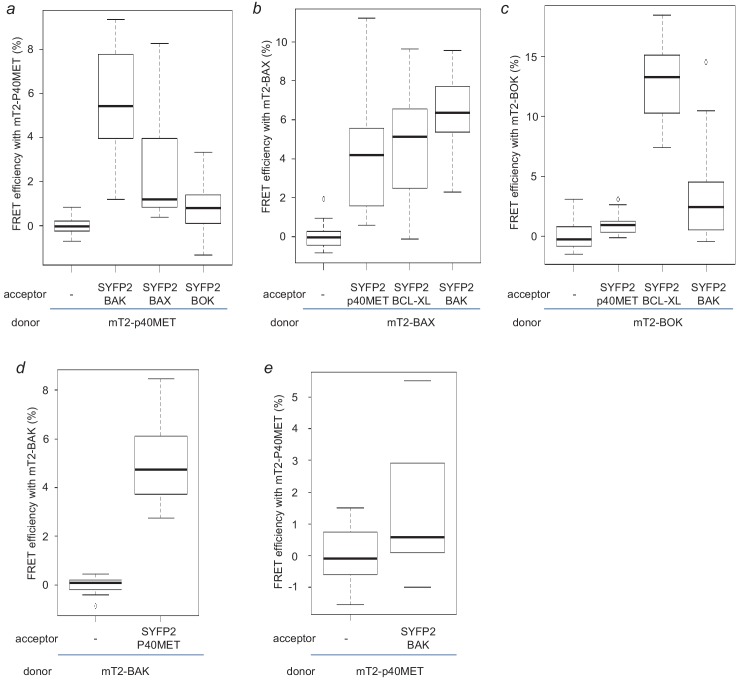
FRET experiments between p40MET and BCL2 family members.(a–c) HEK293 cells were co-transfected with a vector expressing mT2-fused with either p40MET (a), BAX (b) or BOK (c) as a FRET donor and with a vector expressing the indicated SYFP2-tagged acceptors. The fluorescence lifetime of mT2-fused protein was measured by Time-Correlated Single Photon Counting (TCSPC) and the FRET efficiency was calculated with respect to the donor-alone condition. (d–e) IHH cells were co-transfected with a vector expressing mT2 fused with BAK (d), or p40MET (e) as a FRET donor and with a vector expressing SYFP2-tagged p40MET (d) or BAK (e). The fluorescence lifetime of mT2-fused protein was measured by Time-Correlated Single Photon Counting (TCSPC) and the FRET efficiency was calculated with respect to the donor-alone condition.Figure 2—figure supplement 4—source data 1.Source data of Figure 2—figure supplement 4a–e including FRET source data and diagram conception.